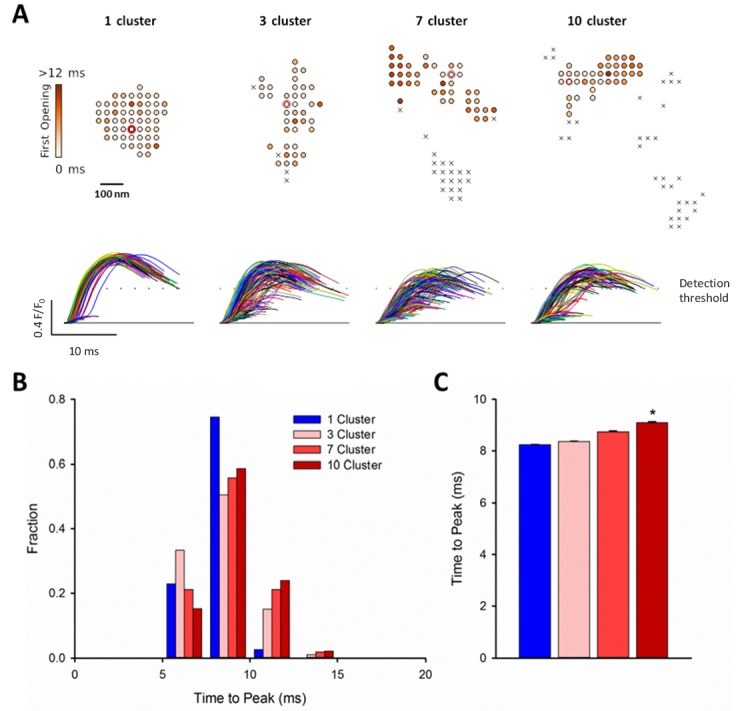
RyR dispersion during HF results in slowing of Ca2+ sparks.To examine whether altered CRU morphology could slow Ca2+ spark kinetics in HF, spark profiles were simulated for a variety of dSTORM-derived RyR configurations. (A) Sparks were triggered by opening a single RyR (circled) which was randomly placed in consecutive simulations (example RyR opening trajectories are shown in the upper panels, with a family of spark time-courses illustrated below). Time to opening was registered for each RyR in the CRU, and the resultant time course of the Ca2+ spark was plotted until the final RyR closure, at which point the simulation was stopped for computational efficiency. Opening times were similar for individual RyRs within a solid, single cluster CRU, and the overall temporal profile of elicited sparks showed rapid kinetics which were rather consistent between consecutive simulations. By contrast, delayed and variable opening times were observed for individual RyRs in multi-cluster CRUs. This resulted in variable and slowed Ca2+ spark kinetics with these CRU configurations, as indicated by temporal spark profiles (A), a right-shifted distribution of time-to-peak measurements (B) and mean data (C). (*=P < 0.05 vs single-cluster CRU).10.7554/eLife.39427.014Figure 6—source data 1.CRU size has little effect on Ca2+spark characteristics in the reported range.Clusters smaller than 15 – 20 RyR exhibit early spark termination due to stochastic attrition, whereas larger clusters are more capable of supporting regenerative release, for which spark termination becomes relatively consistent in time and dependent on depletion of the releasable Ca2+ store. The simulations were started with all RyRs in the open state and allowed to proceed stochastically. For each RyR number, 50 simulations were performed. The plot shows the mean time from the start of the simulation until all RyRs close. Error bars are standard deviations.